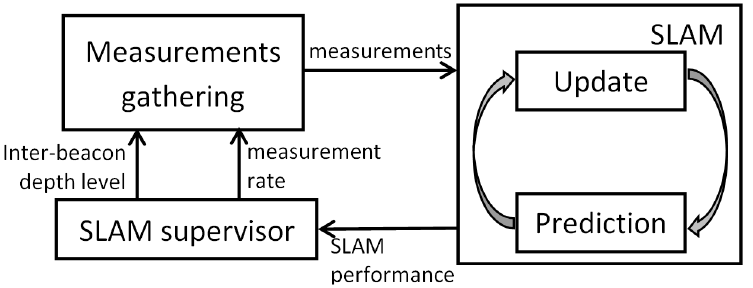
Figure 1. General picture of the proposed